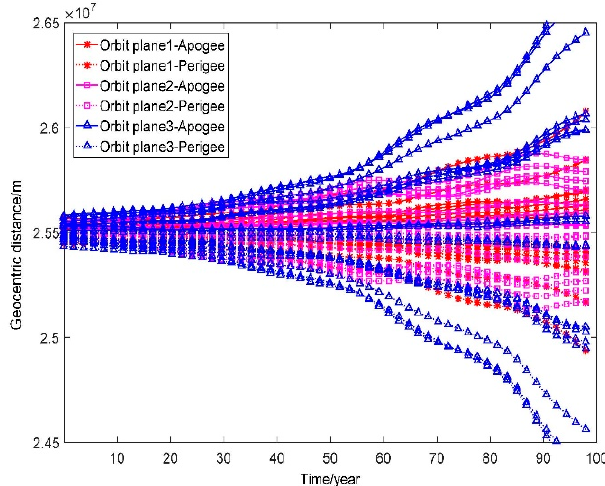
Figure 10. Orbital variations of GLONASS operational satellites over 100 years.